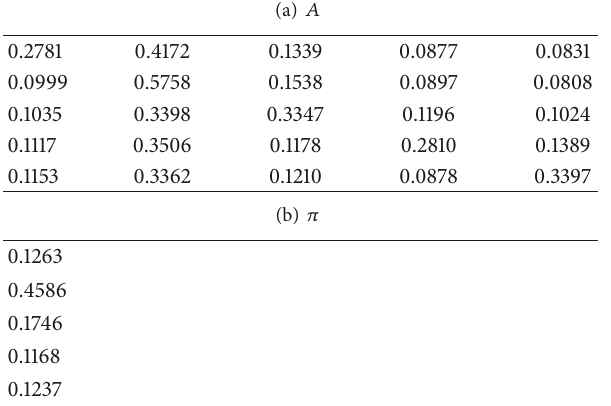
Table 4: Initial state transition matrix 𝐴 and initial state probabili- ties 𝜋 for